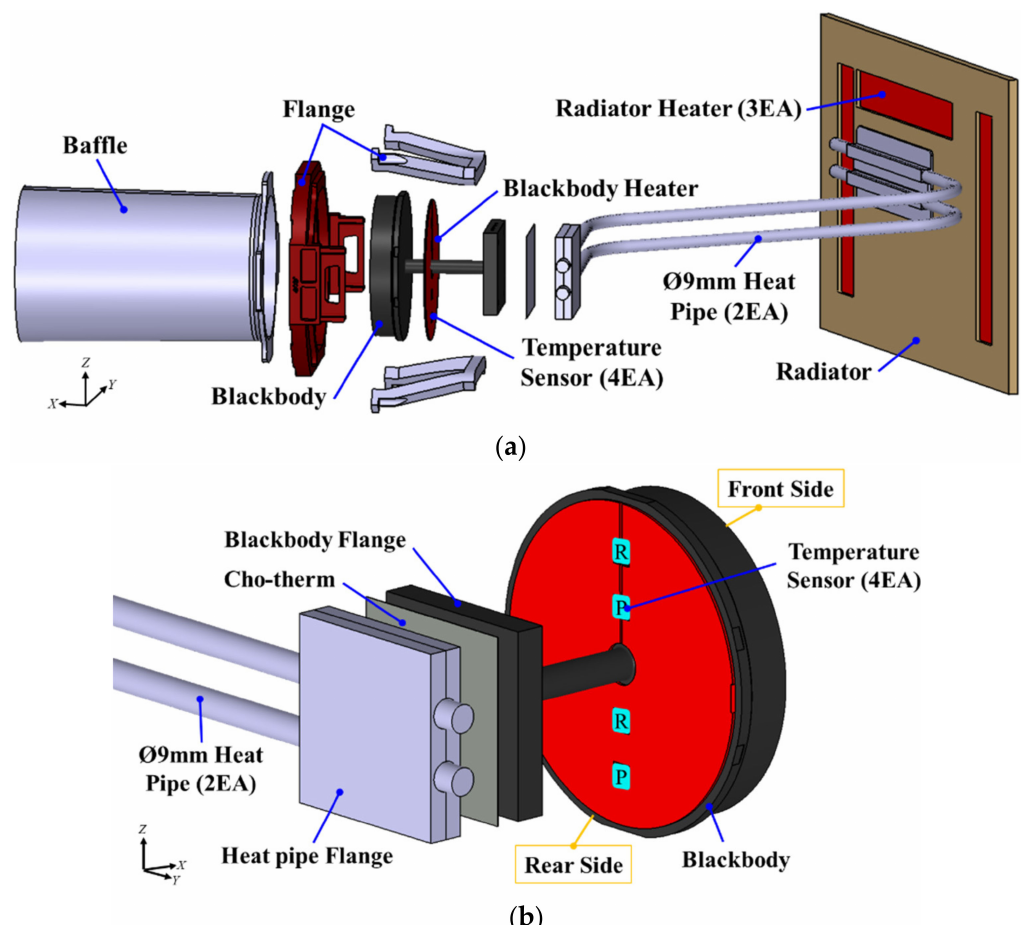
Figure 2. Mechanical configuration of BB. ( a ) Overall view; ( b ) detailed